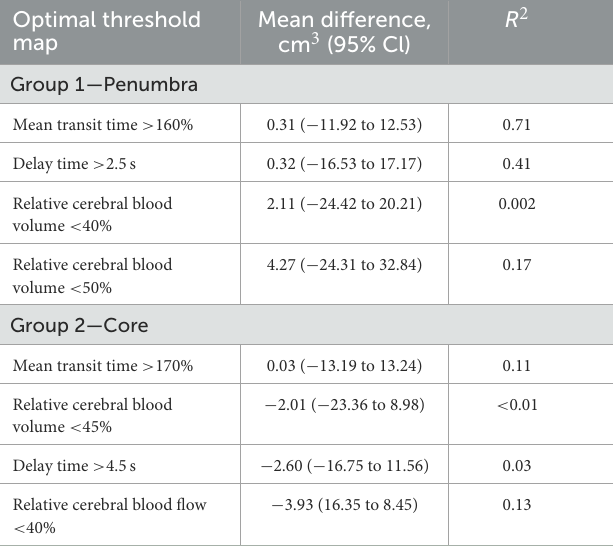
TABLE 2 Optimal perfusion thresholds to define penumbra and core according to volume analysis. Optimal threshold